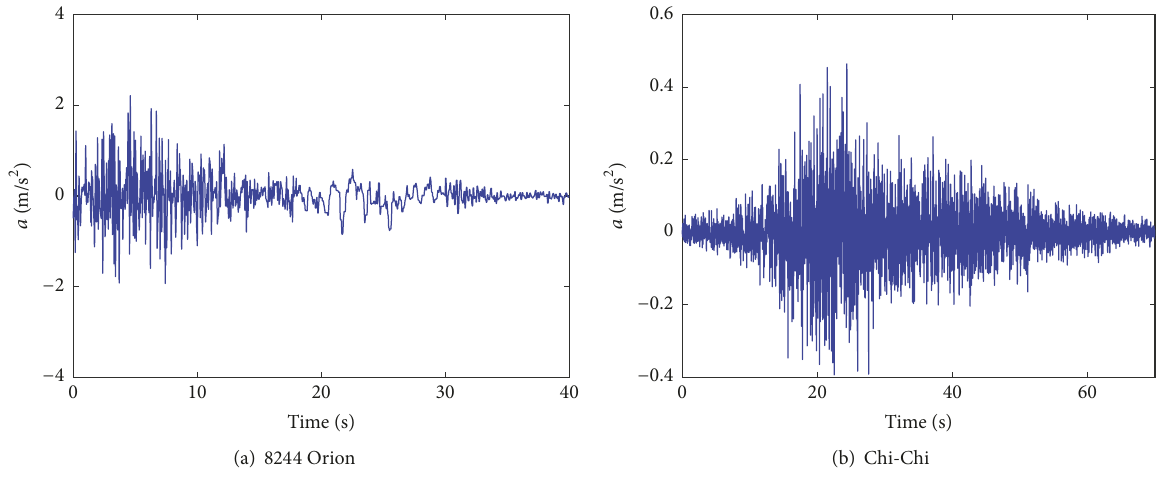
Figure 9: Acceleration time-history of the simulated ground